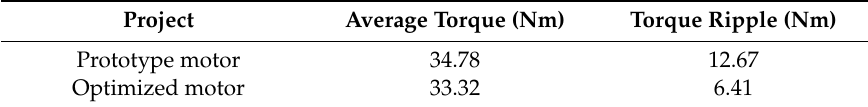
Table 6. Average torque and torque ripple of prototype motor and optimization motor.